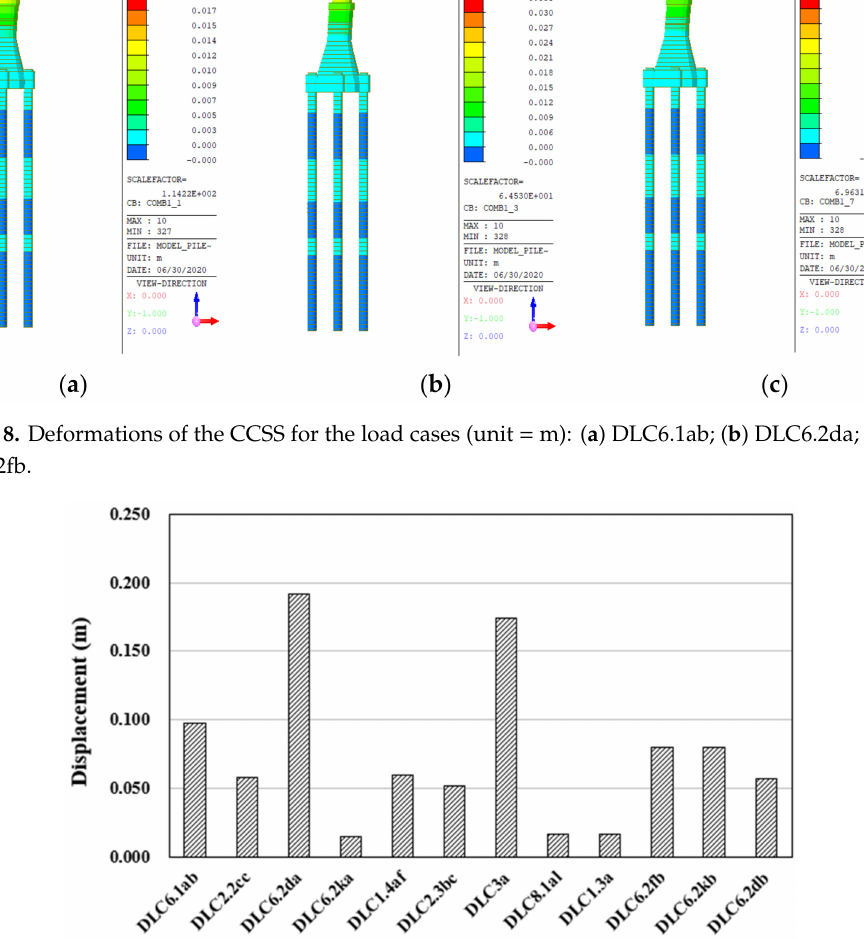
Figure 9. Maximum displacements in each load